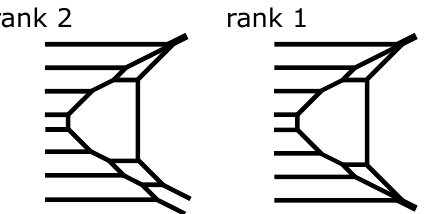
Figure 25. The web diagrams for the theory denoted by ( rank 1 ) and the theory denoted by ( rank 2 ) in table